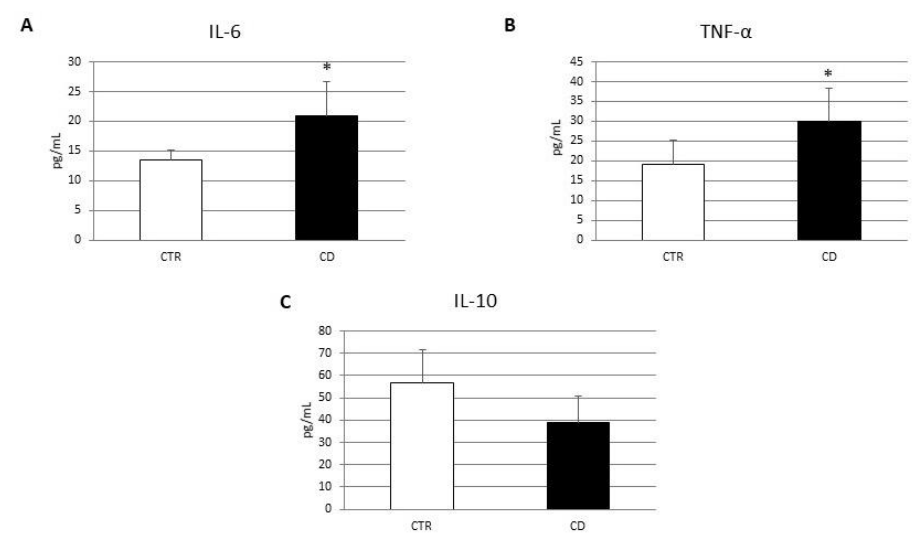
Figure 2. Cytokines concentration evaluation in CD macrophages. IL-6 ( A ), TNF-alpha ( B ) and IL-10